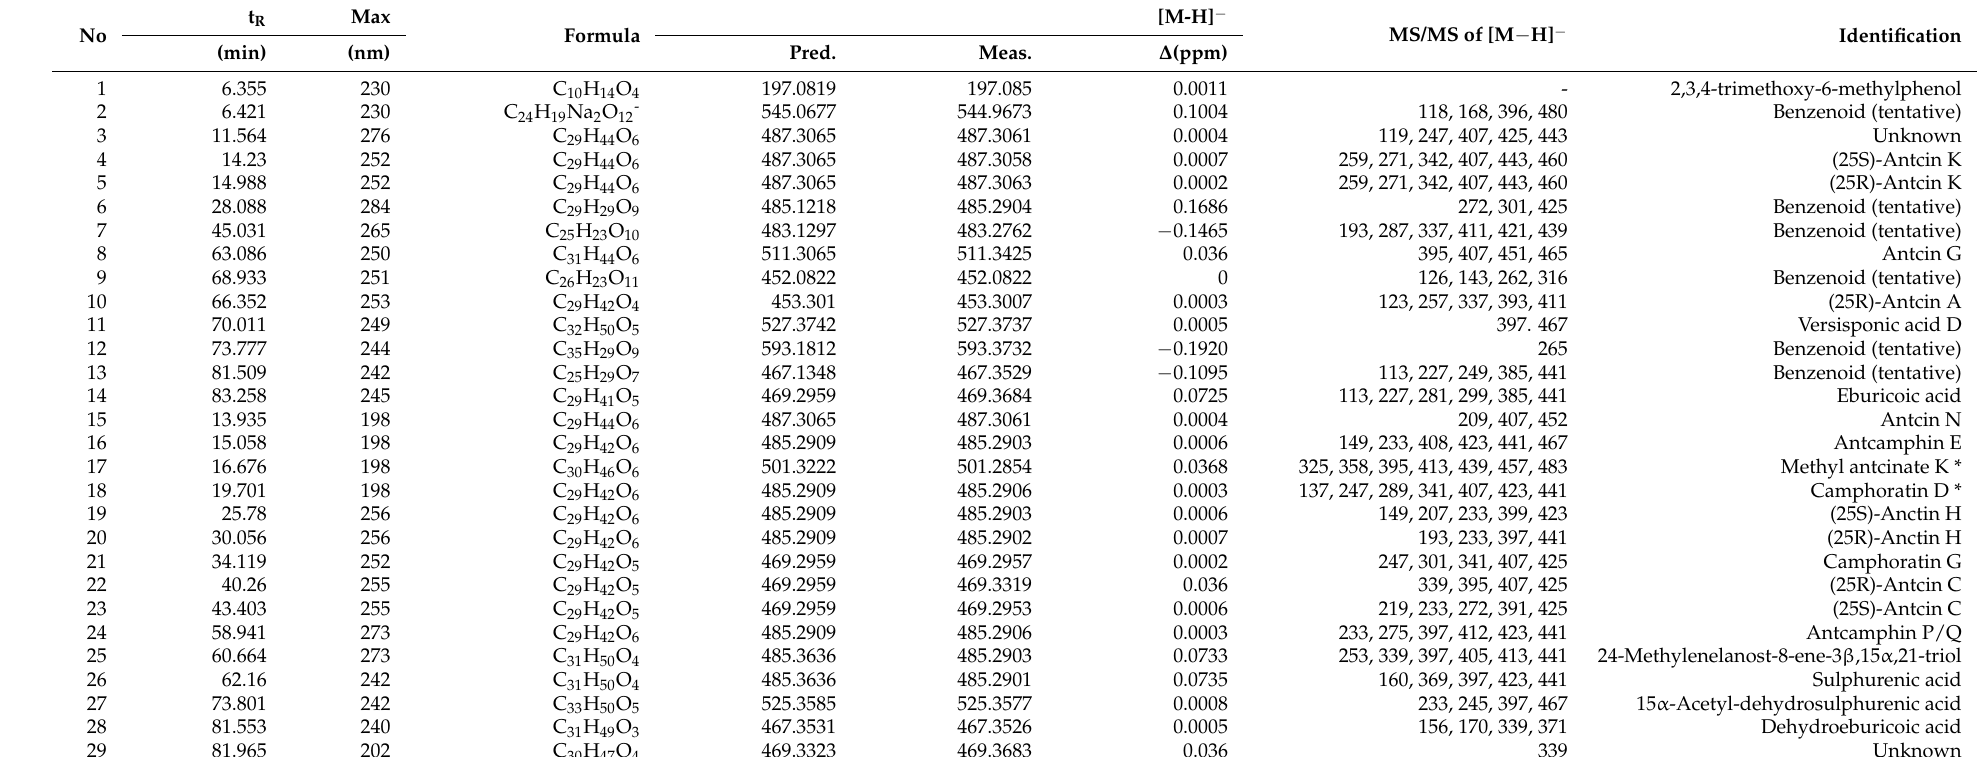
Table 1. Characterization data of phytochemicals in A. cinnamomea by